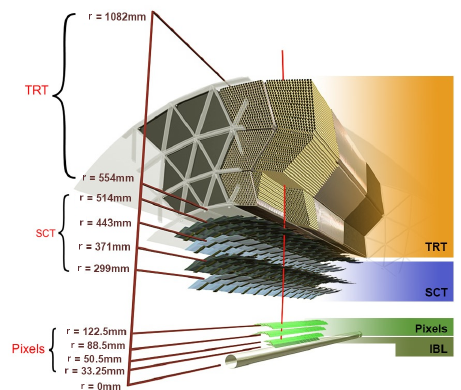
Figure 1: Sketch of the barrel region of the ATLAS inner detector. Figure 2. Schematic overview of the ATLAS Inner Detector tracking system. Shown are the barrel parts of the Pixel, SCT and TRT detectors in ascending order of radii. Figure taken from